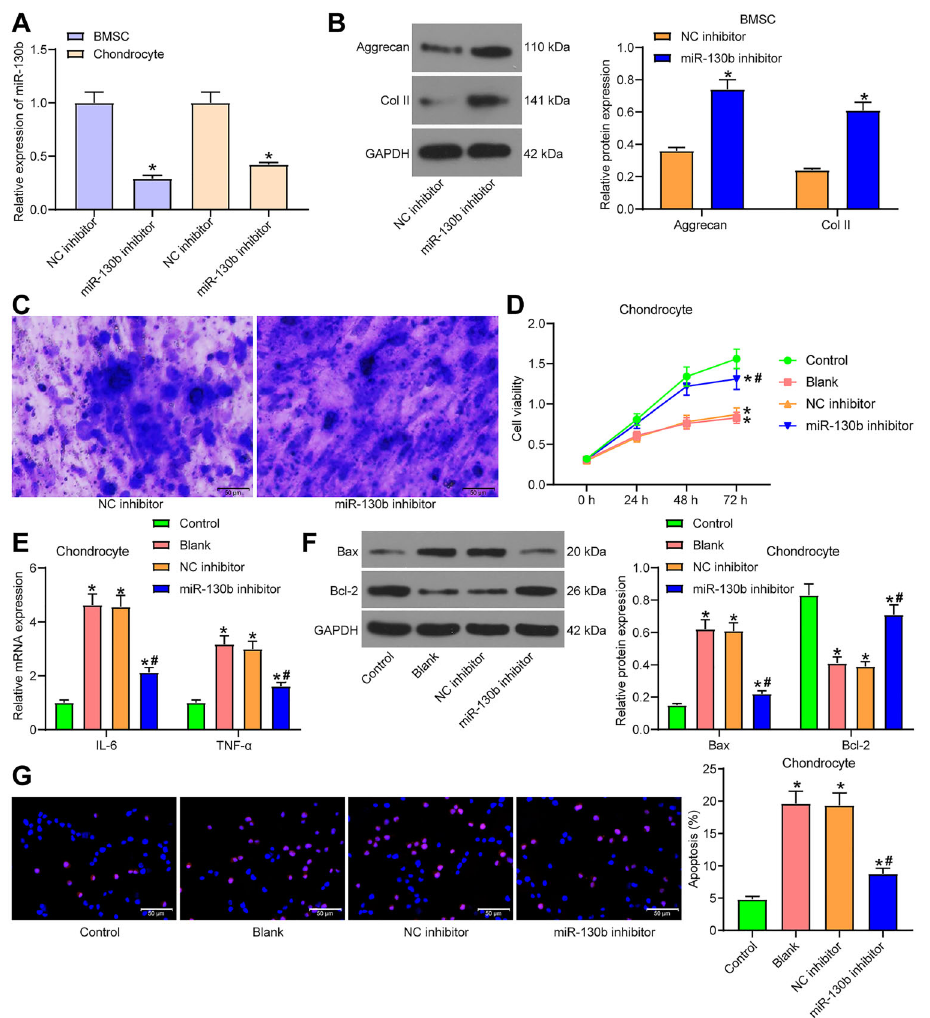
Figure 2. Inhibition of miR-130b promotes chondrogenic differentiation of bone marrow mesenchymal stem cells (BMSCs) and chondrocyte growth. A , The transfection ef fi ciency of miR-130b inhibitor was veri fi ed by RT-qPCR. B , Western blot analysis measured the expression of two cartilage markers in BMSCs. C , The synthesis of extracellular matrix during chondrogenesis of BMSCs was examined by toluidine blue staining (scale bar, 50 m m). D , MTT method was used to measure the viability of interleukin (IL)-1 b -stimulated chondrocytes. E , IL-6 and tumor necrosis factor (TNF)- a expression in IL-1 b -treated chondrocytes was determined by RT-qPCR. F , Levels of apoptosis-related proteins in IL-1 b -treated chondrocytes were measured by western blot analysis. G , Apoptosis rate in IL-1 b -treated chondrocytes was measured by TUNEL assay (scale bar, 50 μ m). *P o 0.05, compared to control; # P o 0.05 compared to the NC inhibitor group. The data in panels A and B were analyzed using one-way ANOVA, and the data in panels D , E , F , and G were analyzed using two-way ANOVA. Experiments were repeated 3 times independently. NC: negative